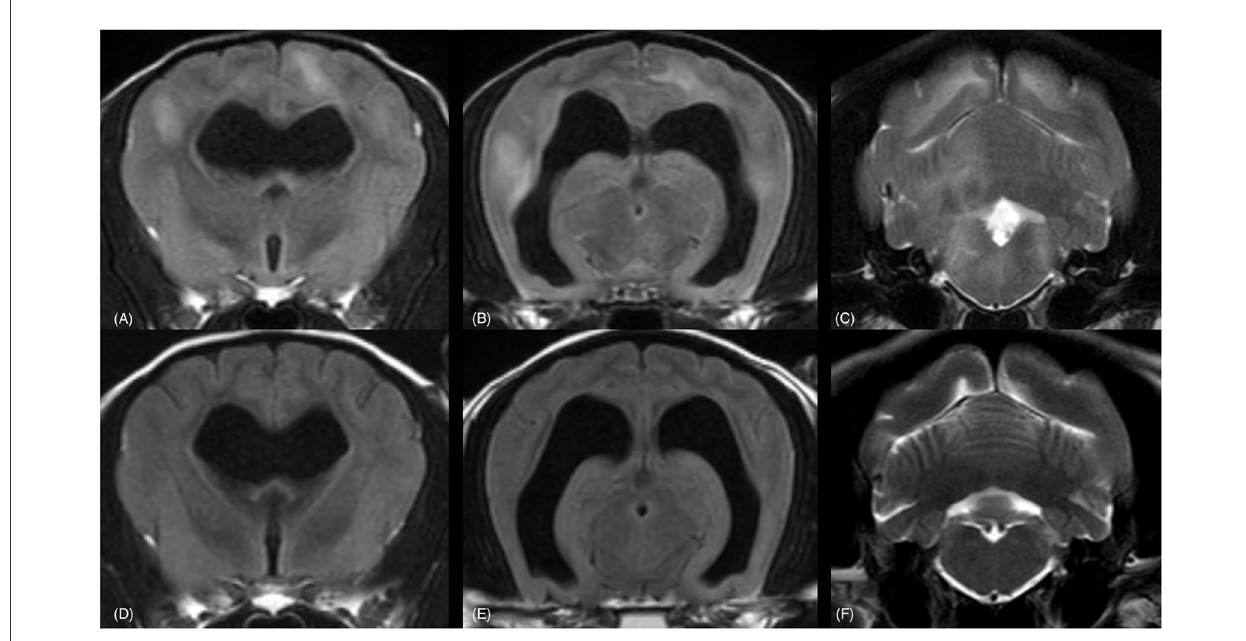
FIGURE2 MRI of a 9-year-old Chihuahua (dog 10). Complete resolution of lesions is visible. In the upper row the brain is imaged at the time of diagnosis (A–C) and in the bottom row the brain is imaged at the corresponding levels three months after radiation therapy (D–F) . The sequences are from left to right in a rostro-caudal direction at the level of the optic chiasm (A, D) , the rostral colliculi and medial geniculate bodies (B, E) and the cerebellar nuclei (C, F) . Transverse FLAIR (TR = 11,000ms, TE = 125ms, TI = 2,800ms, ST = 2.5mm) (A, B, D, E) and T2w (TR = 5,774ms, TE = 100ms, ST = 2.5mm) (C, F) images are provided. TR, Time of Repetition; TE, Time of Echo; TI, Time to Inversion; ST, Slice Thickness. Multifocal, bilateral, asymmetrical, poor defined, hyperintense lesions, mainly affecting the white matter are visible (A–C) . The lesions are in complete remission at the time of follow up—MRI (D–F)